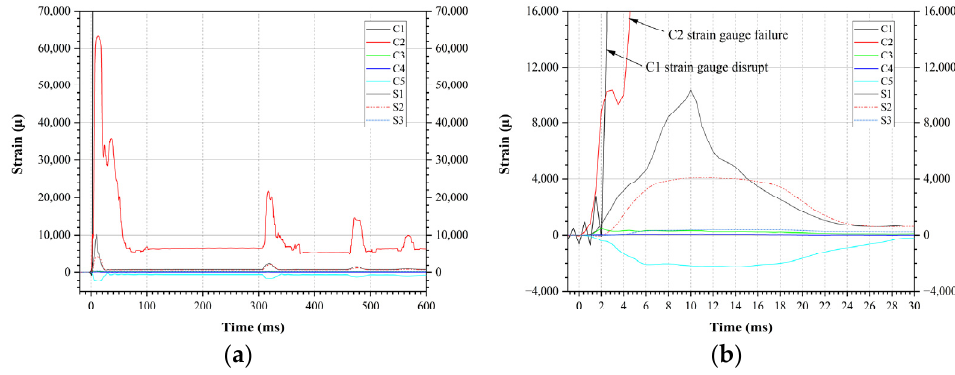
Figure 13. Concrete strain and steel strain of 7MR specimen ( a ) overall, and ( b ) in detail.